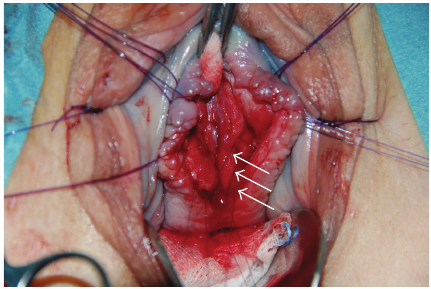
Figure 9: Four thin synthetic monofilament absorbable sutures (three sutures indicated with white arrows) are used to approximate the muscular components of the urethral sphincter. A total of eight sutures were placed to approximate the sphincter edges/fascia surrounding the